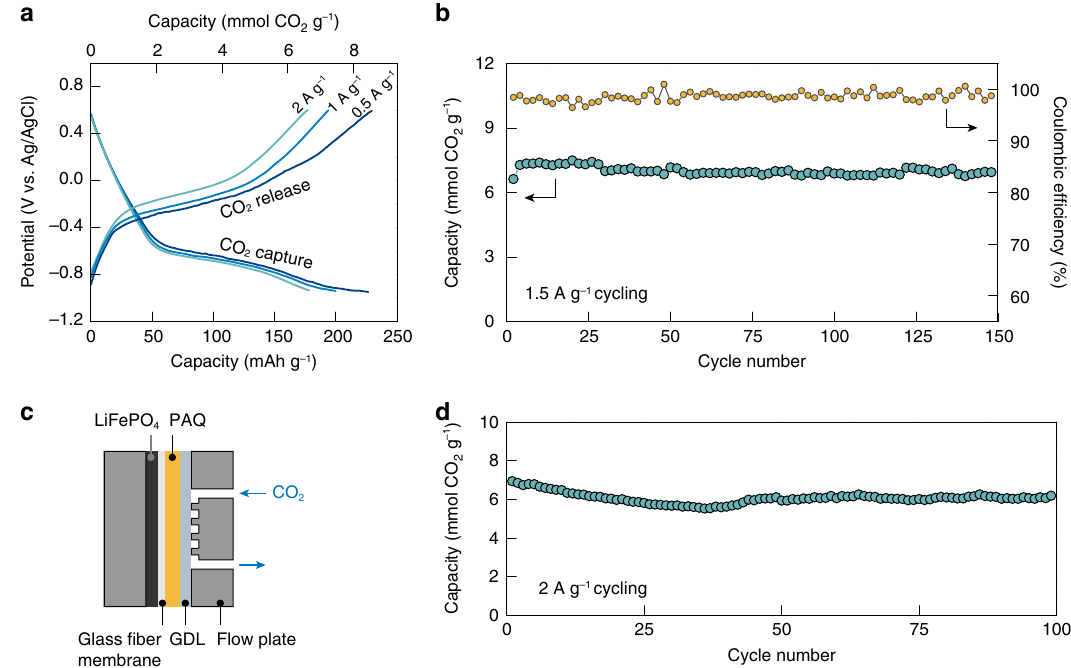
Fig. 5 Electrochemical carbon capture and release with high capacity and stability. a Electrochemical CO 2 capture-release voltage pro fi les at different cycling current densities in 20m LiTFSI. b Long-term cycling stability and Coulombic ef fi ciency of PAQ-CNT in 20m LiTFSI at a high current of 1.5 A g − 1 (capture/release in ~10 min). For ( a ) and ( b ), the mass loading of PAQ on carbon felt was 0.2 mg cm − 2 , LiFePO 4 on Al foil was used as the counter electrode, Ag/AgCl was used as the reference electrode, and the measurements were carried out in a conventional single-compartment electrochemical cell. c Schematic illustrating the con fi guration of the membrane fl ow cell for CO 2 capture-release. PAQ was immobilized on carbon felt at a mass loading of 1 mg cm − 2 , LiFePO 4 coated on Al foil was used as the counter electrode, and the two electrodes were separated by an electrolyte-imbibed glass fi ber membrane. A hydrophobic gas diffusion layer (GDL) was placed on one side of the PAQ electrode and interfaced with continuous CO 2 fl ow. d Long-term cycling stability of the membrane fl ow cell in 20m LiTFSI at a cycling current of 2 A g − 1 . For ( b ) and ( d ), PAQ reduction was carried out at constant current with a cut-off voltage of either − 0.95 V vs. Ag/AgCl or − 1.4 V vs. LiFePO 4 . The oxidation of PAQ-CO 2 was conducted via the CC/CV mode (constant current followed by constant voltage). The cut-off voltage for CC oxidation was either 0.2 V vs. Ag/AgCl or − 0.1 V vs. LiFePO 4 ; and CV oxidation was carried out until the current decayed to 10% of the CC oxidation current. Source data are provided as a Source Data fi